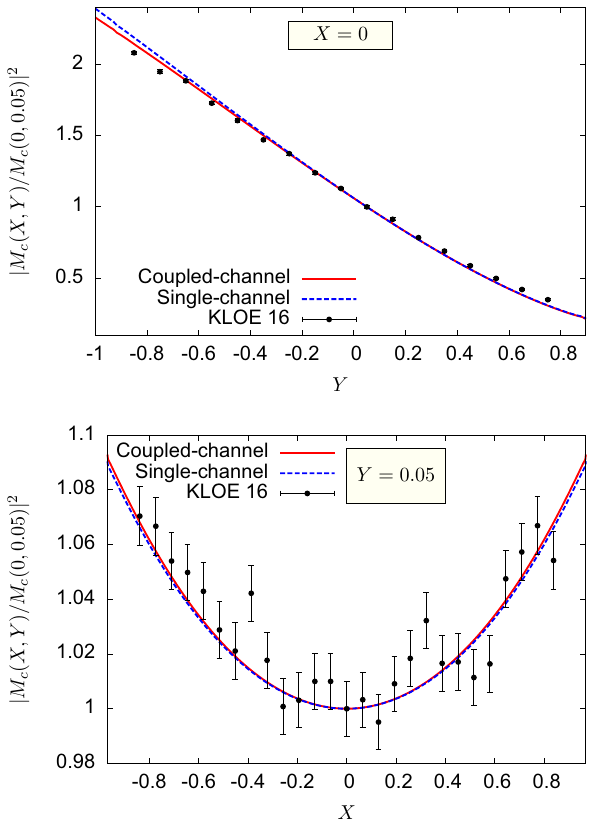
Fig. 9 The computed charged amplitudes squared, normalised to 1 at X = 0, Y = 0 . 05 are shown along the line X = 0 as a function of Y ( upper plot ) and along the line Y = 0 . 05 as a function of X ( lower plot ) and compared with the acceptance corrected results provided by the KLOE collaboration